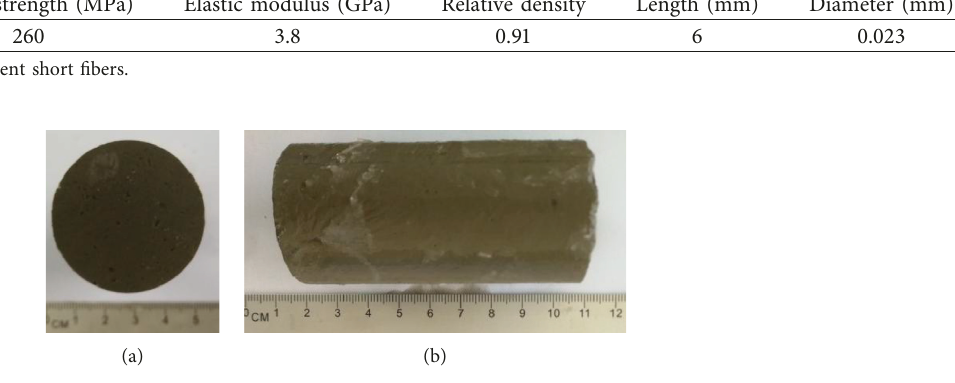
Figure 3: Fiber/cement-modified slurry specimens for unconfined compression test.